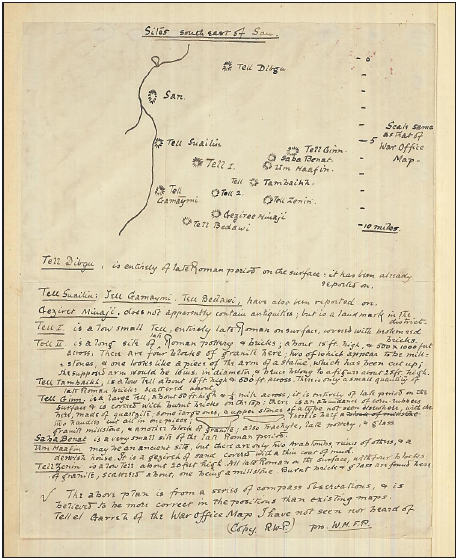
Figure 3: The hand-drawn map found inside Petrie’s 1885 copy of ‘Tanis I’ (Photo Massimiliano